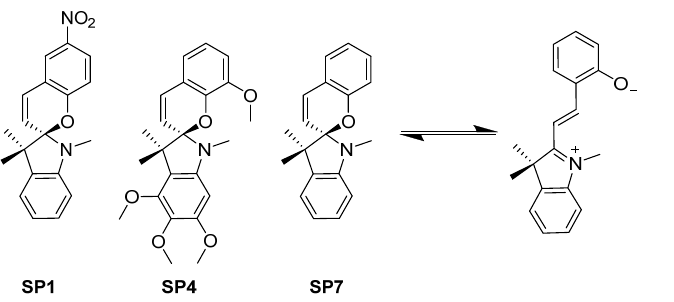
Figure 7. Spiropyrane derivatives that can be photoisomerized with UV-light in an aqueous environment reported by Rastogi et al. [48] .